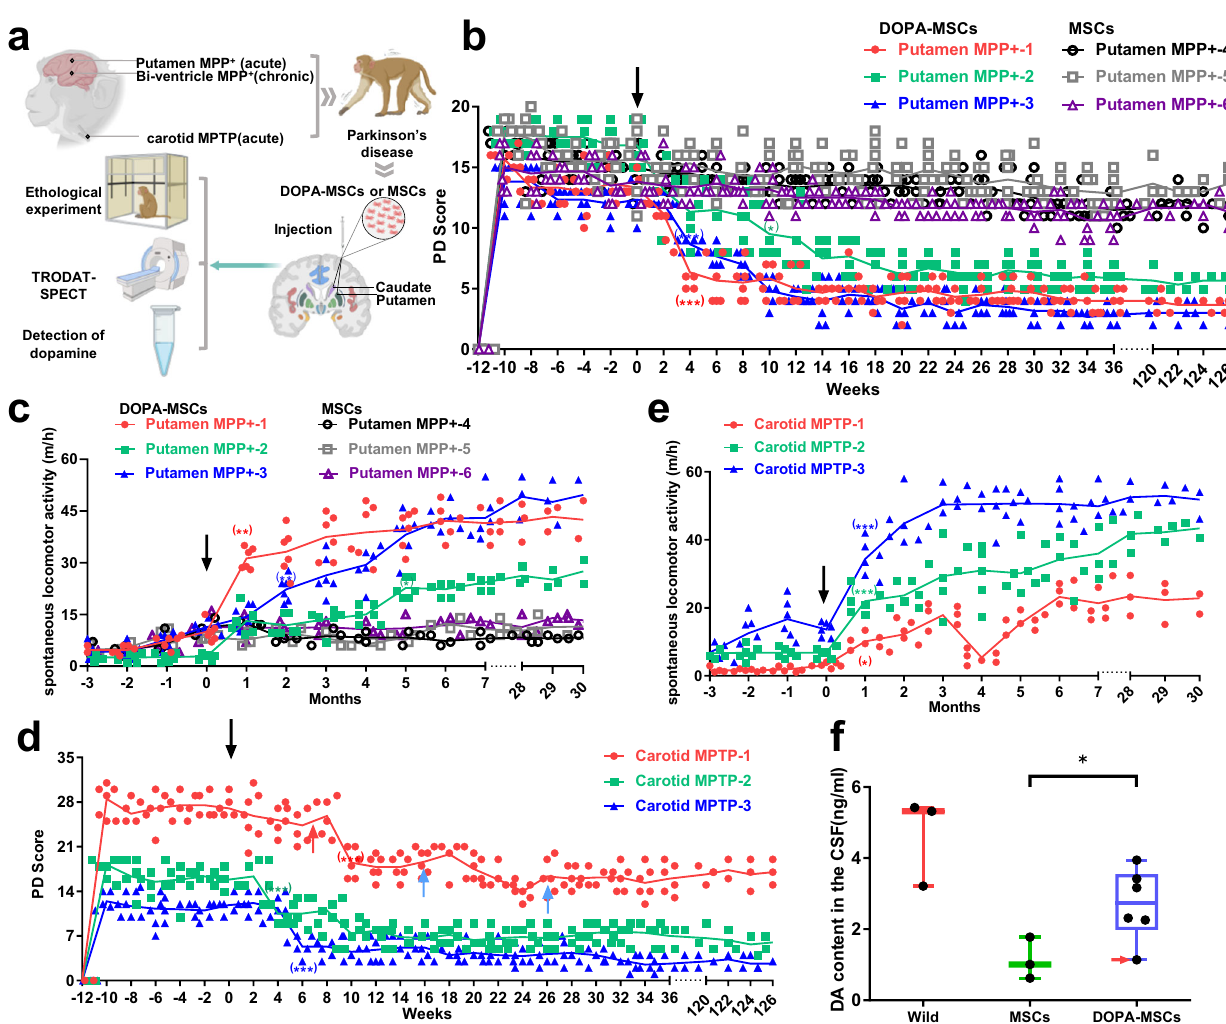
Fig. 3 DOPA-MSC transplantation reverses functional de fi cits in acute hemiparkinsonian monkeys. a A schematic of DOPA-MSC therapy in PD monkeys. This fi gure was created with BioRender.com. b Changes in PD scores from 12 weeks before to 36 weeks after DOPA-MSCs ( n = 3) or MSCs ( n = 3) were transplanted into putamen-lesioned PD monkeys. The values are the average of multiple blinded evaluations ( n = 6). A two-way analysis of variance (ANOVA) with Dunnett ’ s multiple comparisons test was performed. * p < 0.05; ** p < 0.01; *** p < 0.001; c Changes in spontaneous locomotor activity from 3 months before transplantation to 30 months after transplantation of putamen-lesioned monkeys receiving DOPA-MSC ( n = 3) or MSC ( n = 3) transplantation. The value is the mean of 6 tests per month ( n = 6). A two-way analysis of variance (ANOVA) with Dunnett ’ s multiple comparison test was performed. * p < 0.05; ** p < 0.01; *** p < 0.001; d Changes in PD scores of MPTP-induced parkinsonism monkeys ( n = 3) receiving DOPA-MSCs from 3 months before transplantation to 30 months after transplantation. The values are the mean of multiple blinded evaluations ( n = 6). Signi fi cance before and after transplantation was assessed by a two-tailed Student ’ s t -test. The red and blue arrows indicate the second transplantation and intravenous injection of DOPA-MSCs for the Carotid MPTP-1 monkey, respectively. e Changes in spontaneous locomotor activity from 3 months before transplantation to 30 months after transplantation of MPTP- induced parkinsonism ( n = 3) receiving DOPA-MSC transplantation. Signi fi cance before and after cell transplantation was assessed by a two- tailed Student ’ s t -test. The red color represents the Carotid MPTP-1 monkey, the green color represents the Carotid MPTP-2 monkey, and the blue color represents the Carotid MPTP-3 monkey, respectively. f Quanti fi cation analysis of dopamine concentration in the cerebrospinal fl uid of DOPA-MSC-treated monkeys ( n = 6), MSC-grafted monkeys ( n = 3), and wild monkeys ( n = 3). Data are presented as the mean ± s.d. Signi fi cance was assessed by a two-tailed Student ’ s t -test. The red arrow indicates the data of Carotid MPTP-1